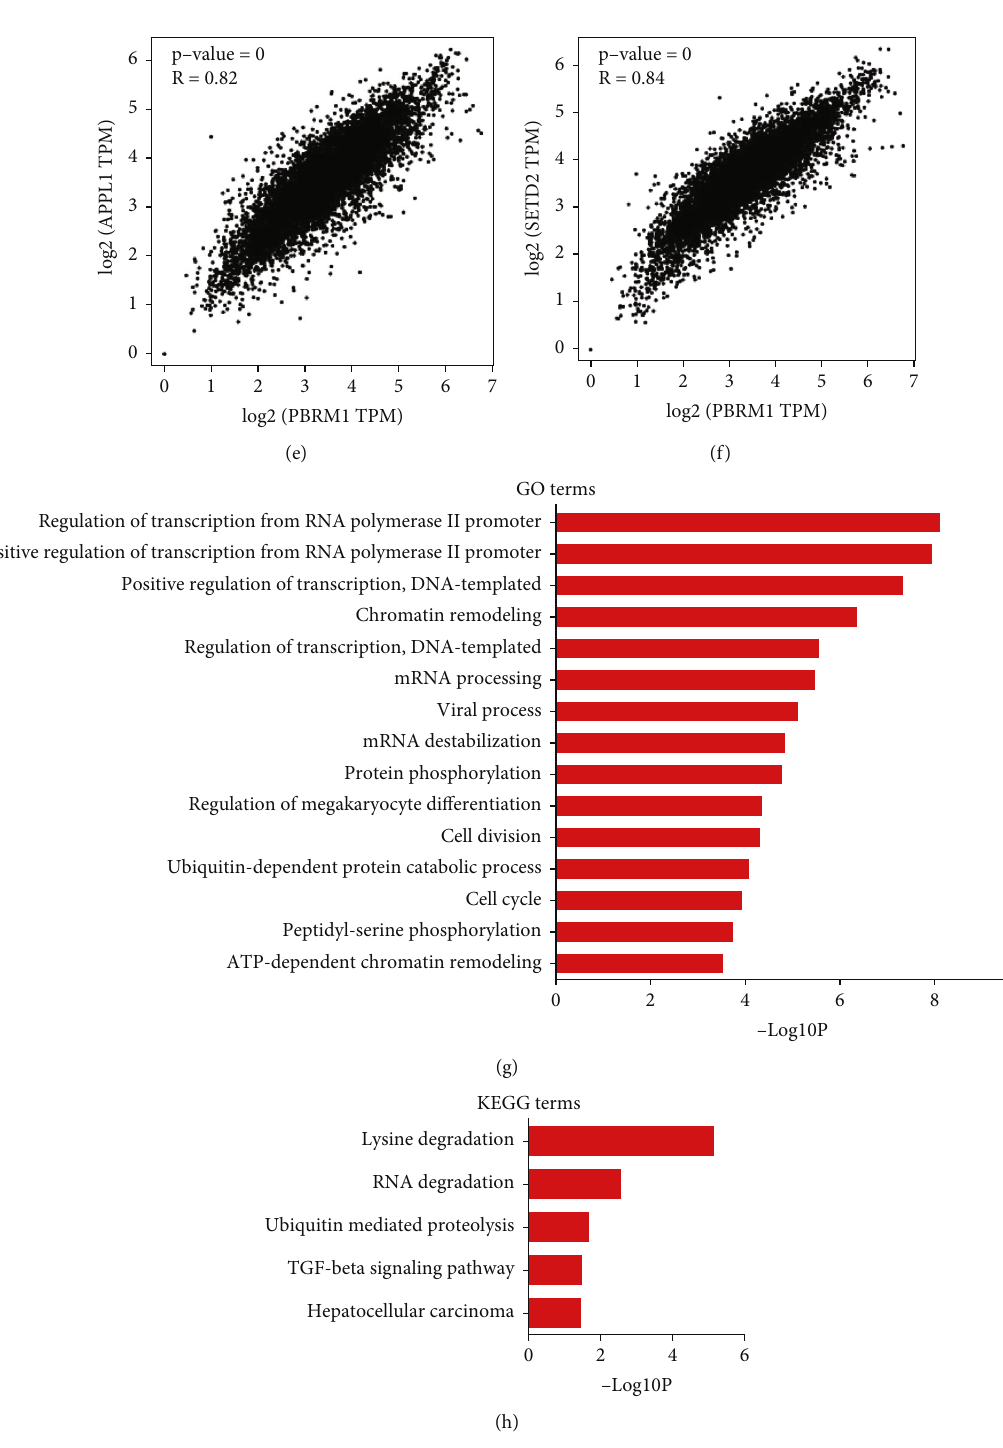
Figure 6: PBRM1-associated genetic expansion and pathway study. (a) Tandem protein network diagram of PBRM1 binding protein determined experimentally. Colored nodes represent individual proteins that have been identi fi ed. (b – f) Expressive correlation among PBRM1 and typical genes (RAD54L2, DENND6A, DCP1A, APPL1, and SETD2) of the greatest PBRM1-related genes in TCGA projects determined by GEPIA2. (g, h) GO and KEGG pathway study according to the PBRM1-correlated